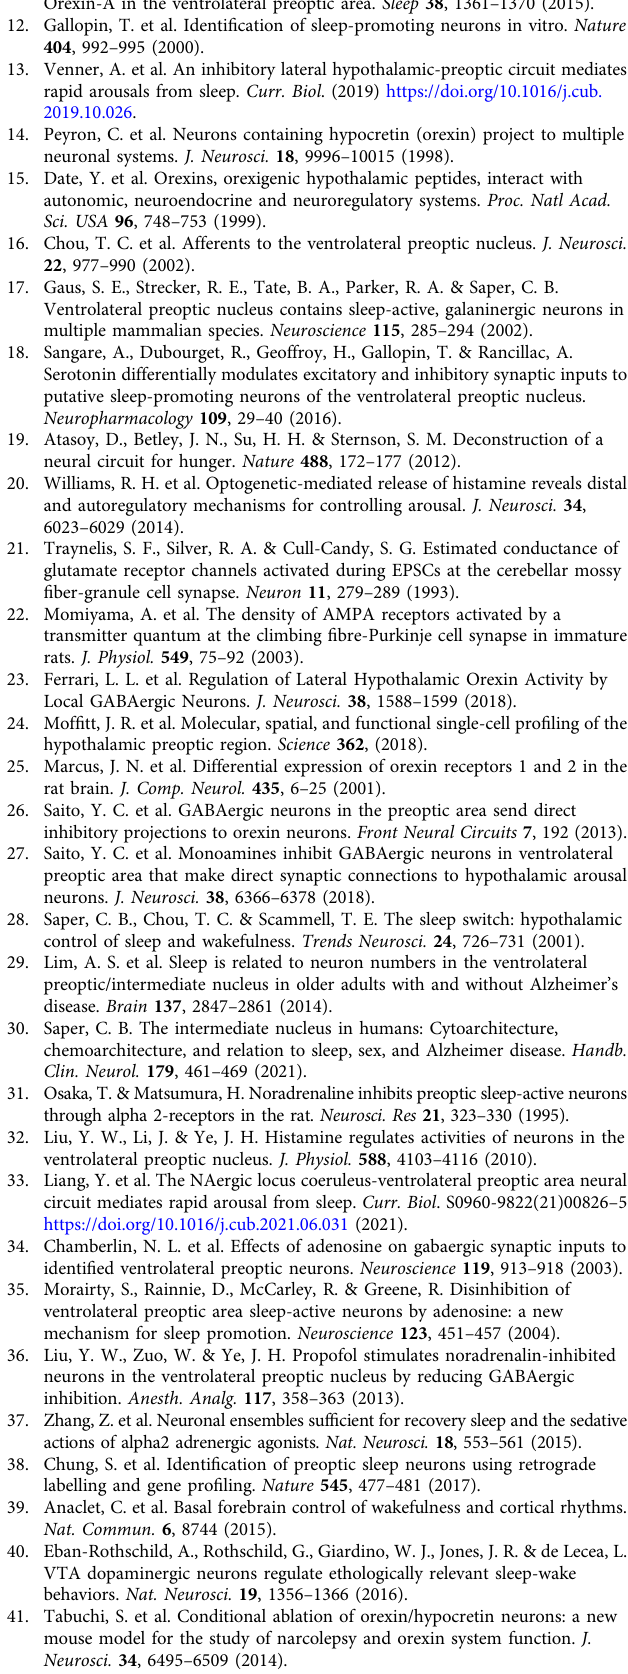
Supplementary Fig. 5: an example of double labelling for TdTomato (and AAV- DIO-GFP ) immunolabeling and Vgat mRNA in Vgat-IRES-Cre mice injected with AAV-DIO-TdTomato (and AAV-DIO-GFP ) into the VLPO. This labelling was conducted in n = 4 Vgat-IRES-Cre mice. Supplementary Fig. 6b: an example of double labeling for biocytin and TdTomato. This labelling was conducted in n = 3 recorded neurons distributed in n = 3 slices from n = 2 Gal-IRES-Cre mice. Sup- plementary Fig. 6c: an example of recordings from a TdTomato labeled VLPO- GABA/Gal neurons. For these experiments we recorded from n = 49 labeled VLPO GABA/Gal neurons in n = 23 slices from n = 21 Gal-IRES-Cre mice. Supple- mentary Fig. 7a: an example of recordings from a TdTomato labeled VLPO GABA/ Gal neurons. For these experiments we recorded from n = 9 labeled VLPO GABA/Gal neurons in n = 9 slices from n = 7 Gal-IRES-Cre mice. Supplementary Fig. 8a: